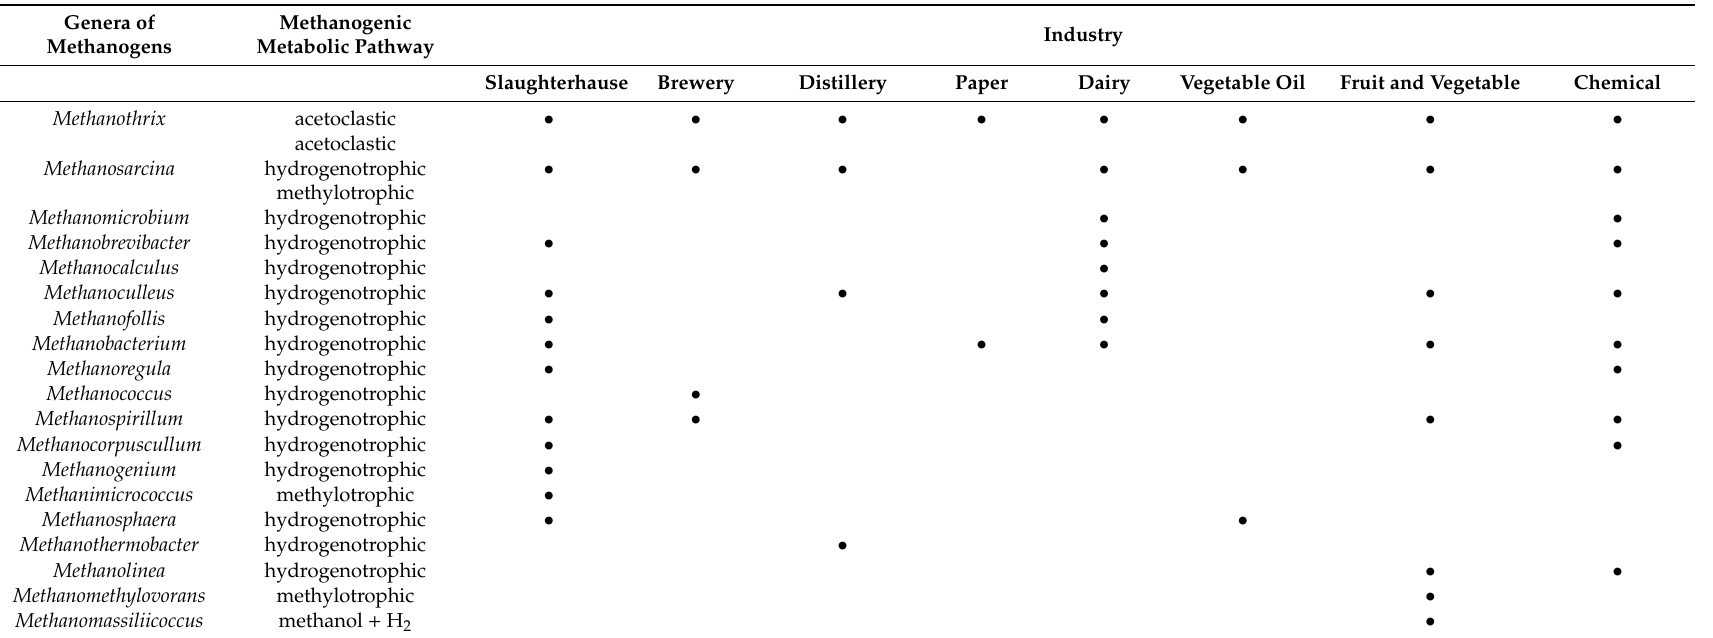
Table 7. Methanogens prevailed in anaerobic bioreactors treating industrial